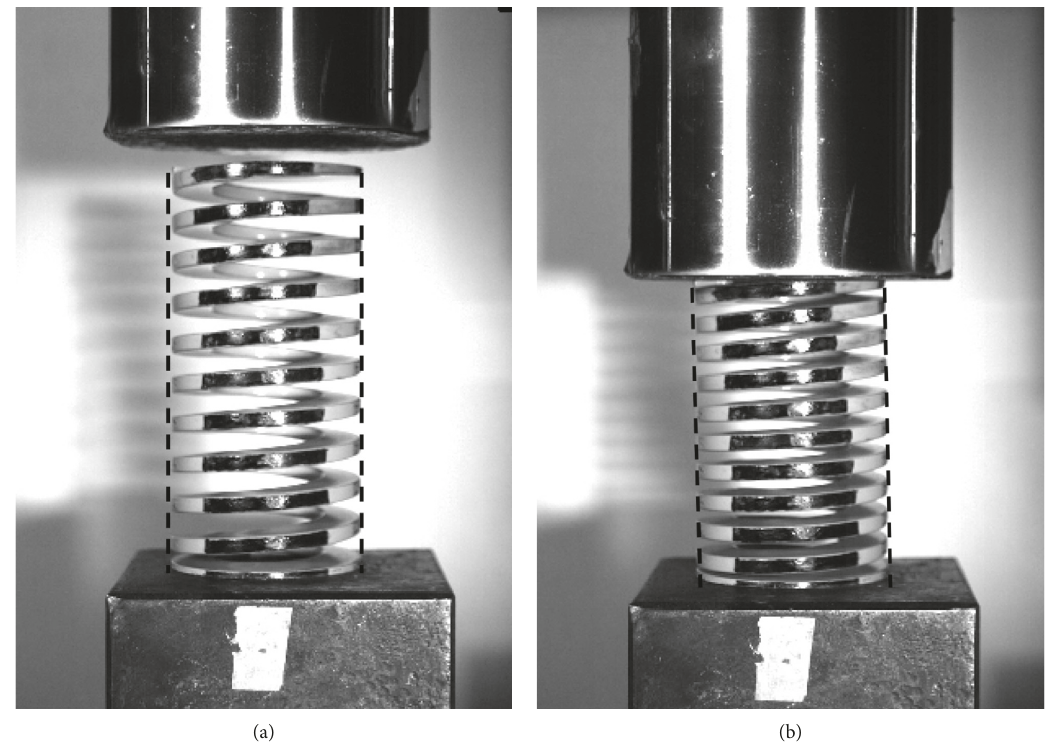
Figure 5: Deformation of spring under impact at height of 60mm: (a) initial length of spring; (b) maximum deformation of